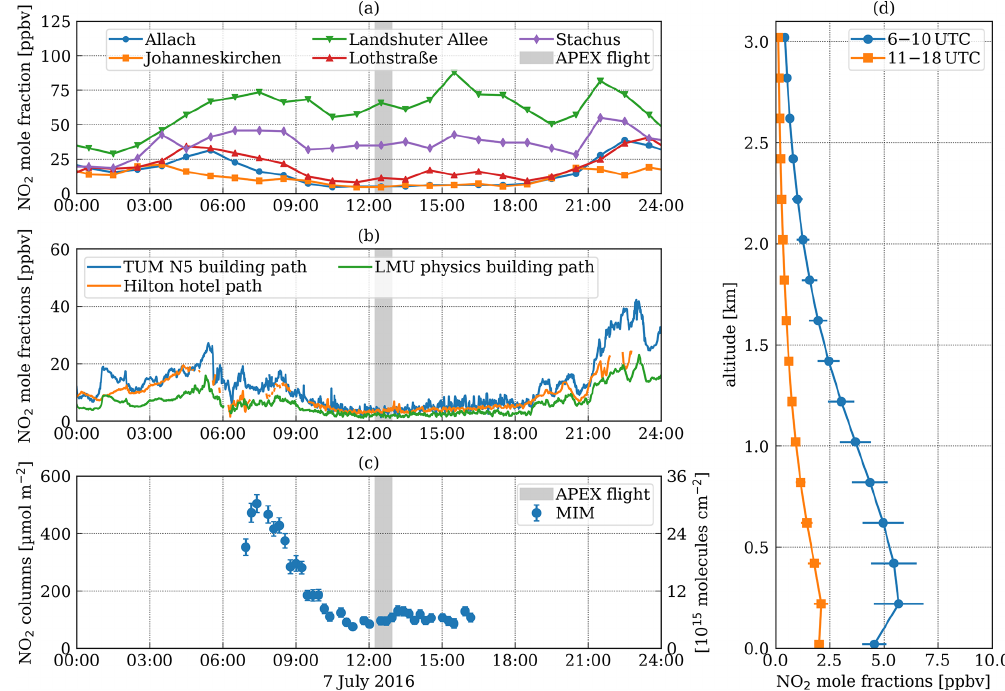
Figure 3. Time series of NO 2 mole fractions from (a) monitoring stations and (b) the LP-DOAS systems. (c) Time series of vertical column densities and (d) mean NO 2 profiles from the MAX-DOAS instrument on the MIM’s rooftop on 7 July